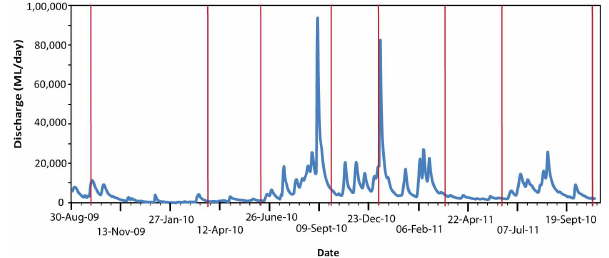
Fig. 2. Variation in discharge of the Ovens River at Peechelba (Fig. 1) during the study period (September 2009 to October 2011; Victorian Water Resource Data Warehouse, 2011). Low flow con- dition prior to June 2010 was due to drought, followed by several flood events in September to December 2010. Times of sampling are indicated by the red